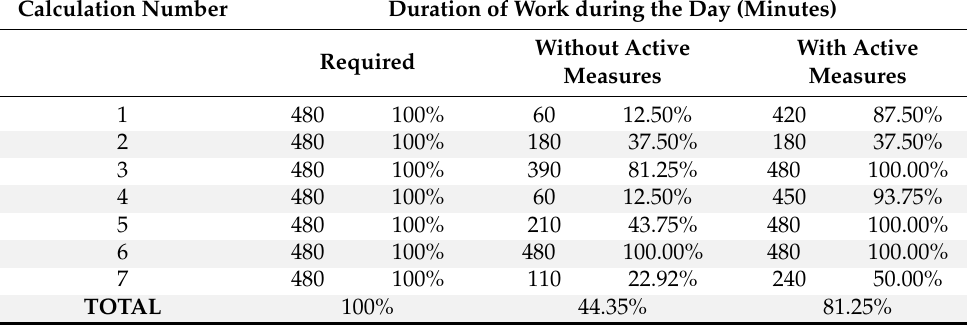
Table 26. Working time with the machine during the work